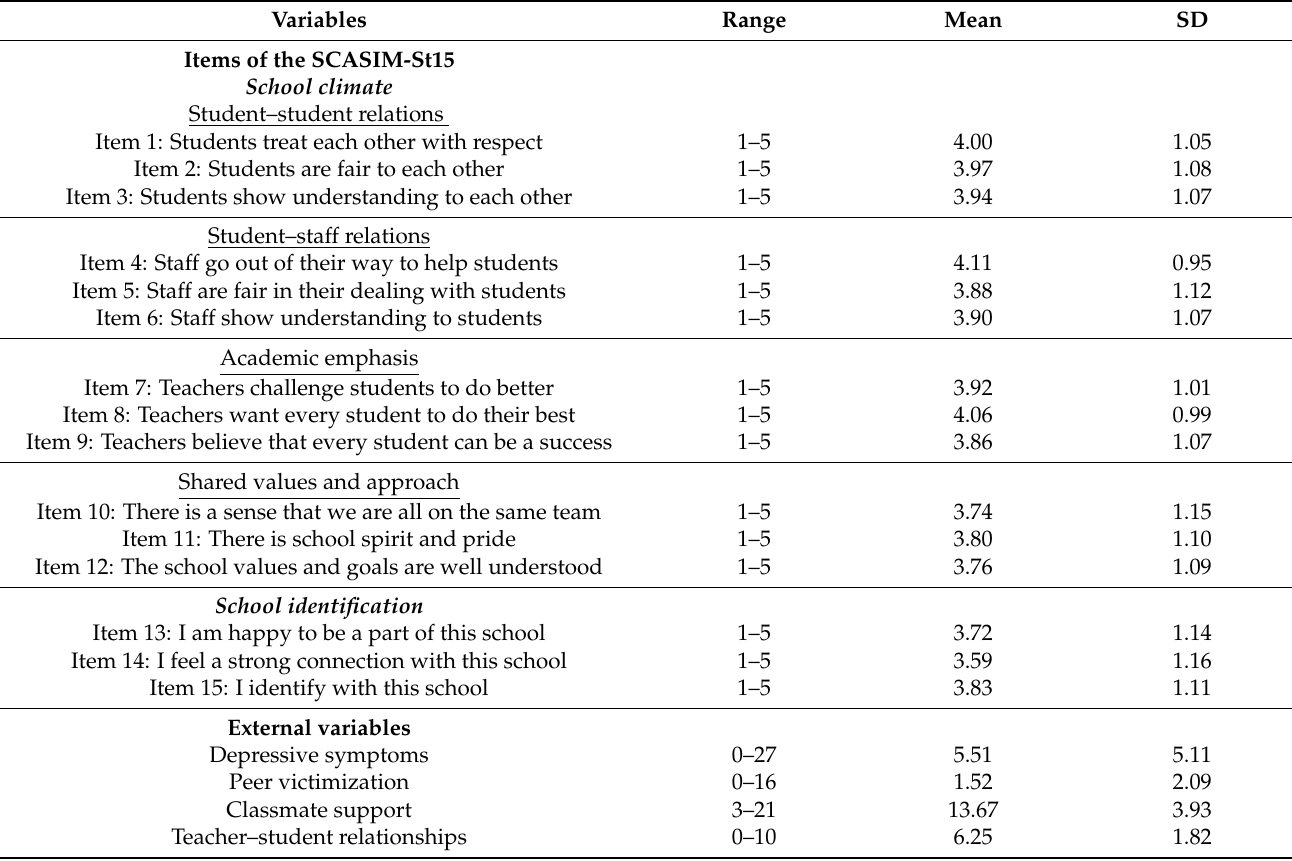
Table 1. Descriptive statistics (n =